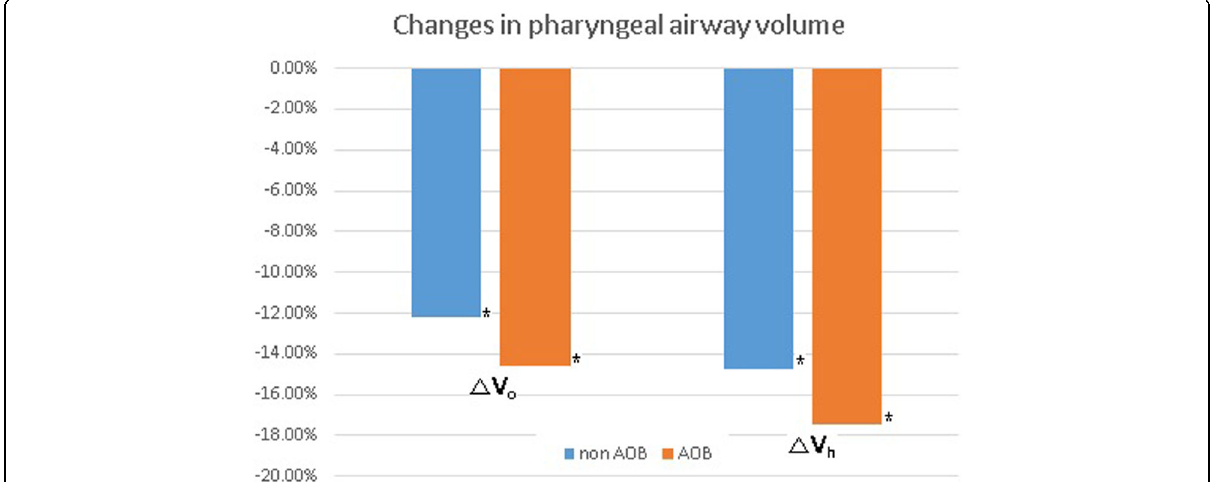
Fig. 4 The average changes in linear distance and cross-sectional area in the pharyngeal airway. All parameters were decreased postoperatively in the retropalatal level and retroglossal level, while S at the retroglossal level was significantly decreased in the AOB group (* p =